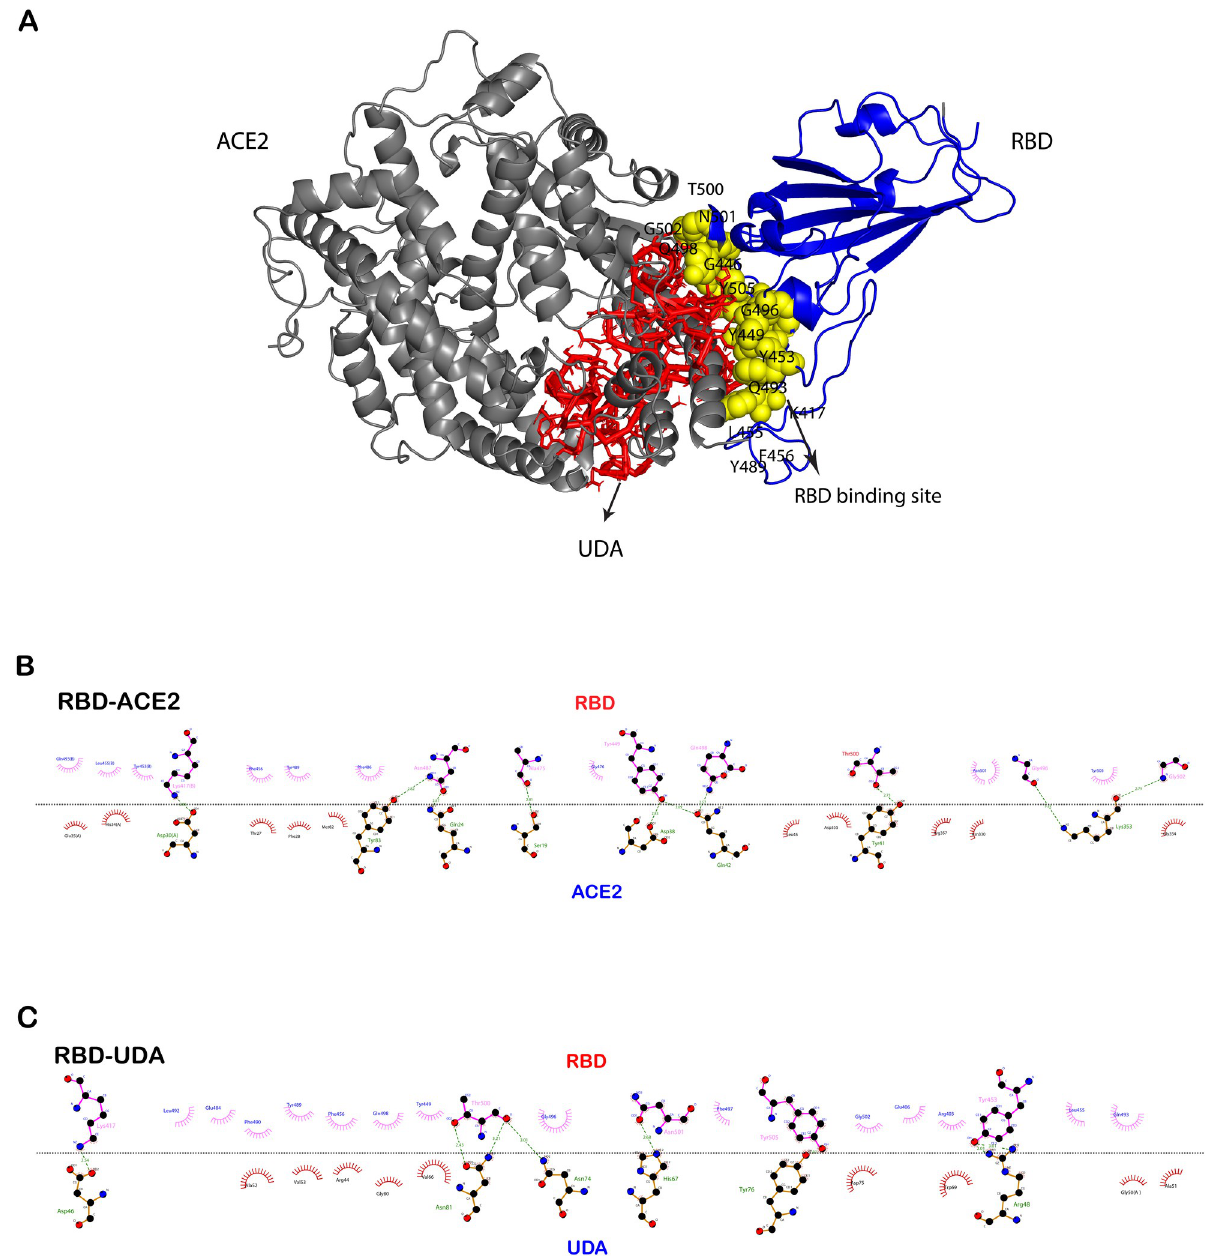
Fig 3. Comparison of the UDA-RBD docked complex with the crystal structure of RBD-ACE2 (a). LigPlot + diagrams of RBD-ACE2 crystal structure (b) and docked RBD-UDA interactions (c).